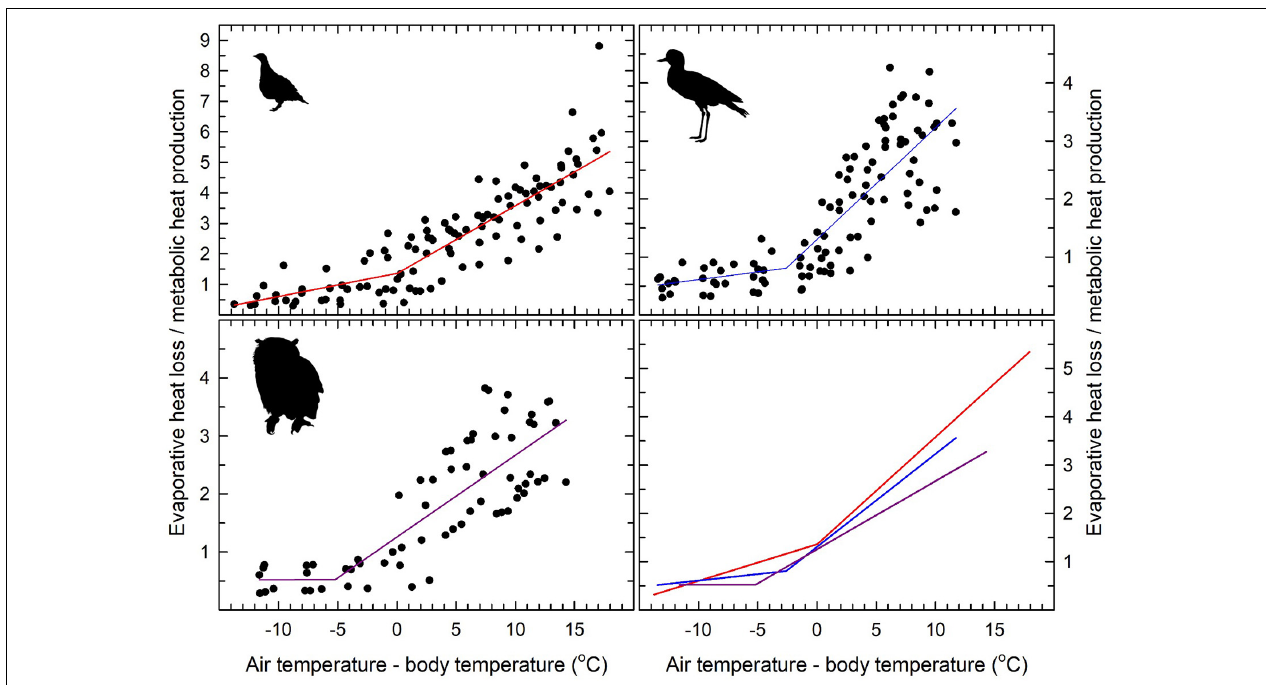
FIGURE 4 | Ratio of evaporative heat loss (EHL) and metabolic heat production (MHP) as a function of the gradient between air temperature ( T air ) and body temperature ( T b ) in Namaqua sandgrouse ( Pterocles namaqua ; top left), spotted thick-knees ( Burhinus capensis ; top right) and spotted eagle-owls ( Bubo africanus ; lower left). Segmented linear regression models fitted to each data set are shown using solid lines, with inflection T air values and slopes for relationships between EHL/MHP and T air – T b provided in Table 2 . The lower right panel shows the regression models for all three species plotted on the same axes for comparative purposes. Sources of the bird silhouettes are provided in the Figure 1